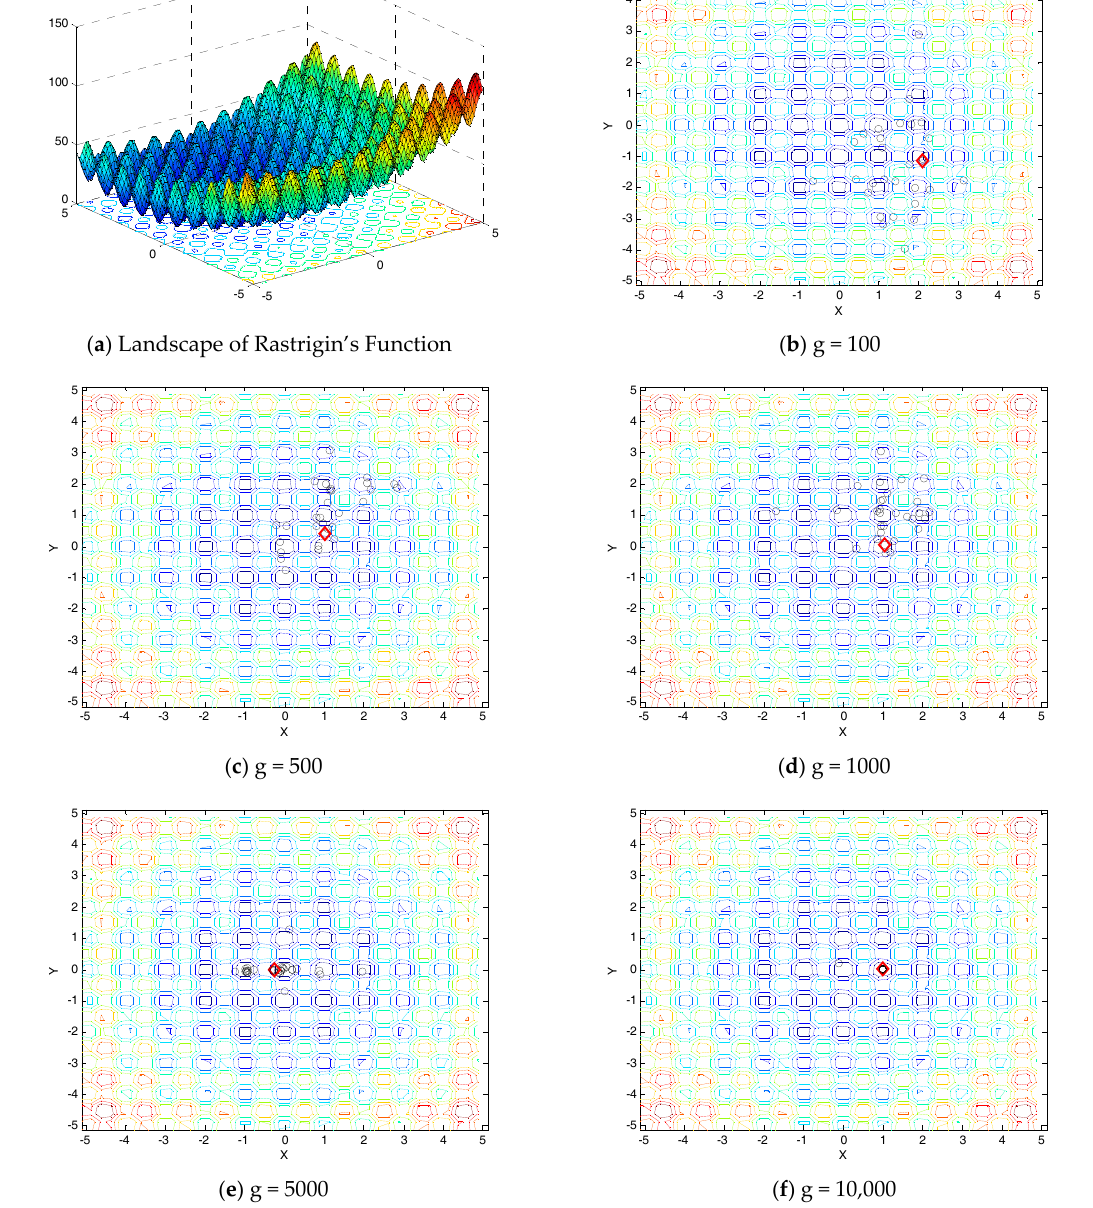
Figure 8. Population distribution at various generations in an evolutionary process of PTBO.